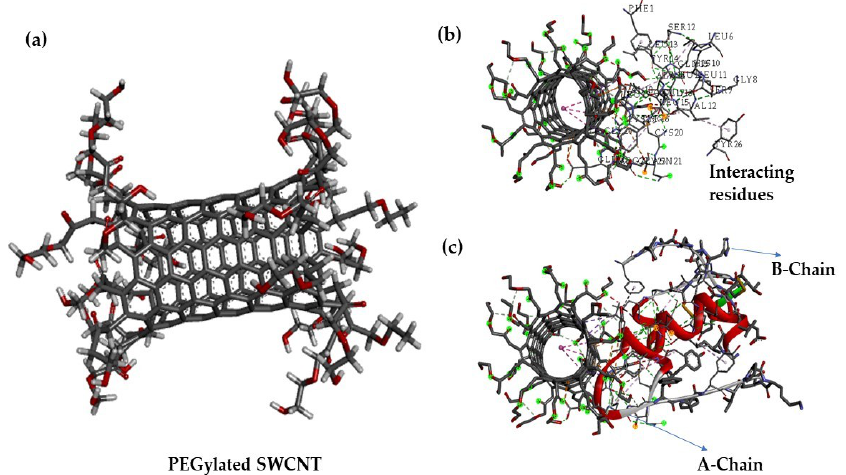
Figure 1. Three-dimensional representation of, ( a ) covalently functionalized single-walled carbon nanotubes with polyethylene glycol (PEGylated SWCNTs); ( b ) binding site interactions among insulin and PEGylated SWCNTs predicted by FireDock webserver; and ( c ) the binding of insulin A-chain and B-chain onto PEGylated SWCNTs. All interactions are visualized using the Discovery Studio visualizer.